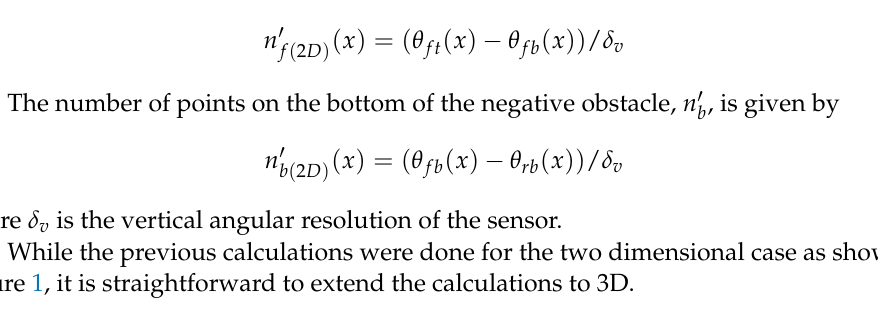
The number of points on the bottom of the negative obstacle, n (cid:48)